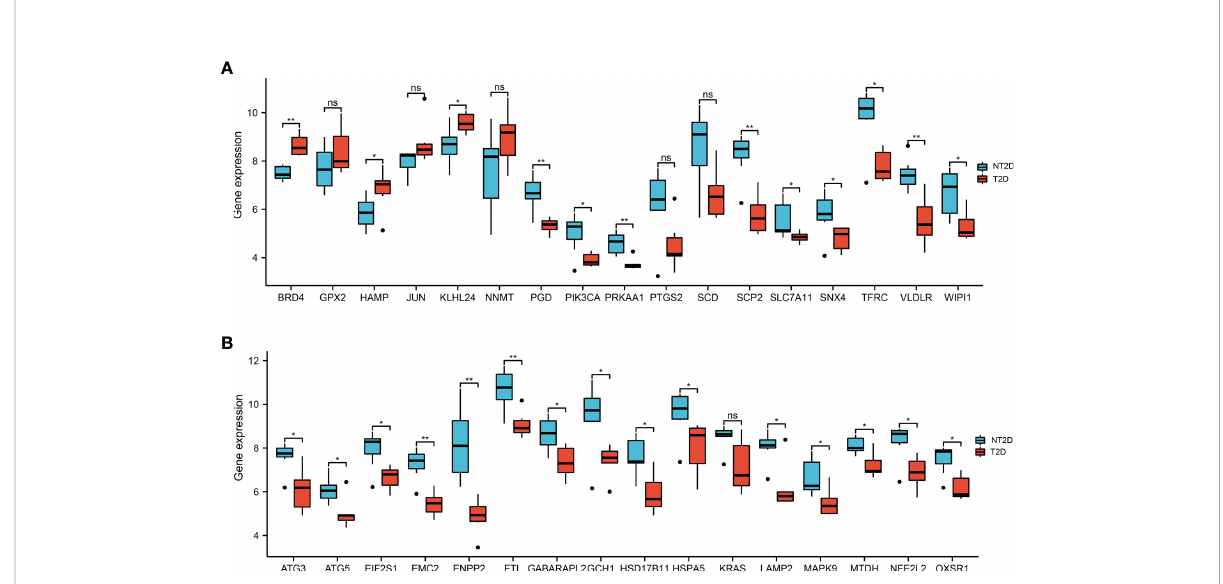
FIGURE 4 The boxplot of 33 ferroptosis-related DE-mRNAs in T2D and NT2D islet samples. (A) The boxplot of top 17 ferroptosis-related DE-mRNAs in T2D and NT2D islet samples. (B) The boxplot of last 16 ferroptosis-related DE-mRNAs in T2D and NT2D islet samples. Statistical analysis was performed with the Wilcoxon rank sum test. ns, not signi fi cant; * P < 0.05; ** P < 0.01.